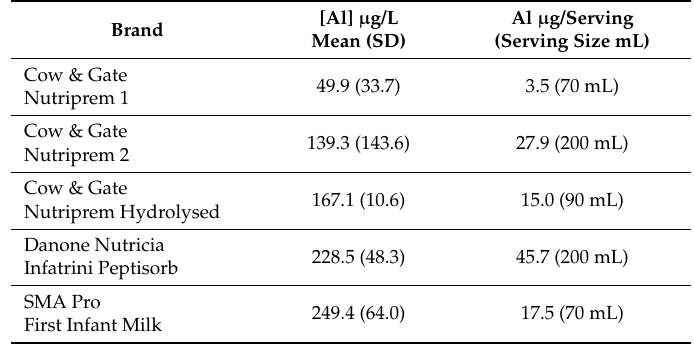
Table 1. Aluminium in ready-to-drink infant formulas designed for preterm and intrauterine growth restriction (IUGR) infants. Mean and SD are given, n =